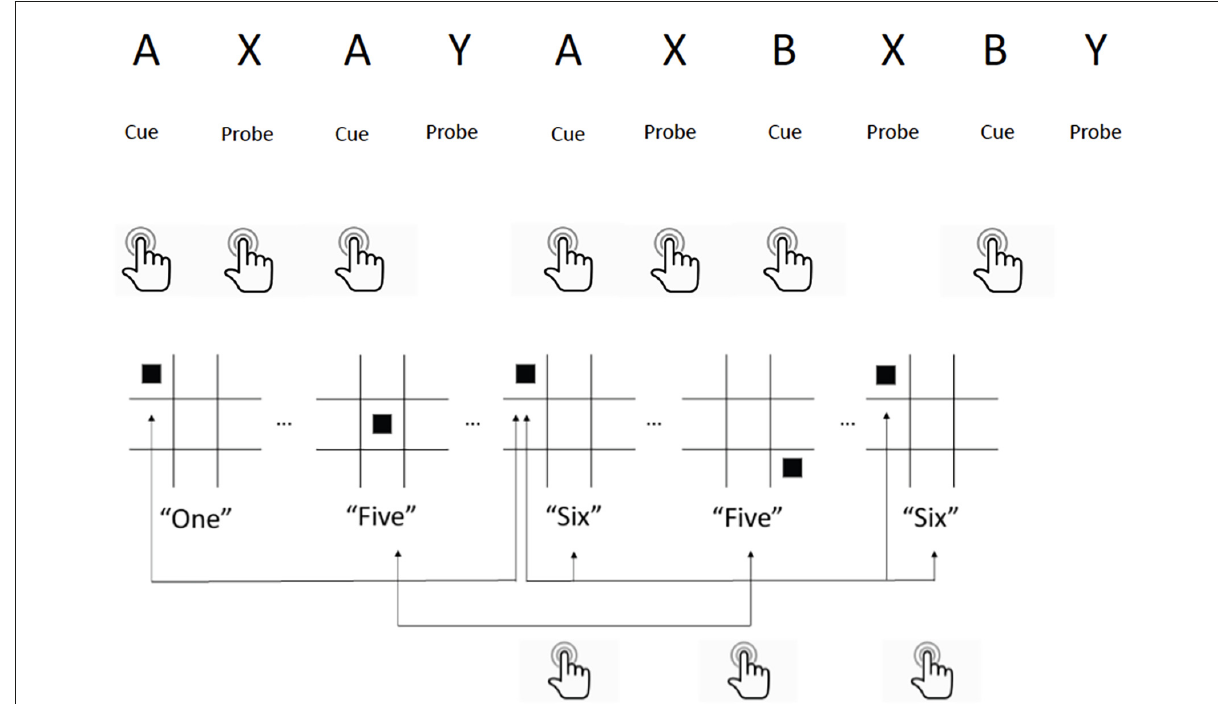
FIGURE2 Executive function training tasks utilized during tDCS sessions. Top : AX-Continuous Performance Task. Participants press a button for every cue (“A”) followed by the probe (“X”) that appears on a computer screen. If the probe (“Y”) appears after cue (“A”) they are instructed to ignore, and if cue (“B”) appears, they press the button and ignore all probes following it. Bottom : Multimodal Working Memory N-Back Task. Participants watch a computer screen for a square to appear on the board, and listen for a number to be spoken simultaneously. They press a button if either the square location or the number spoken are identical to the instance before it (1-back) or two instances before it (2-back). If both are identical, they press a different button. Example shown is for